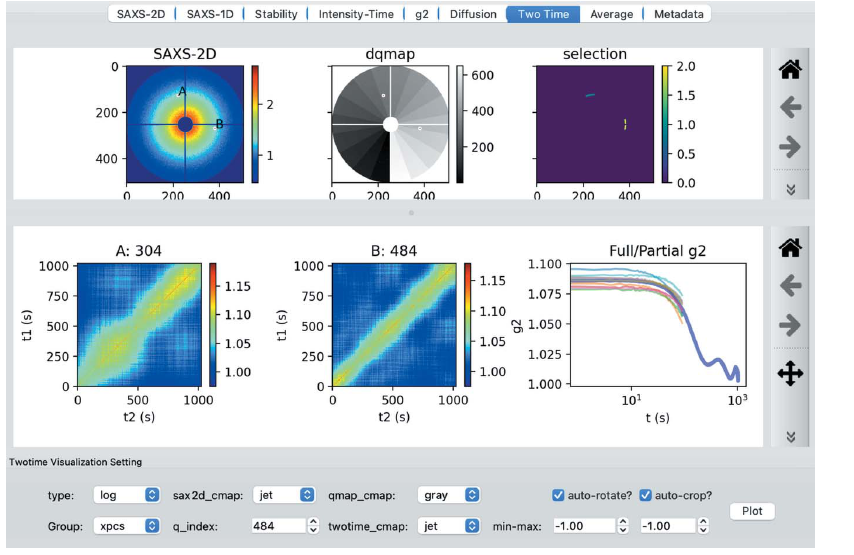
Figure 5 Two-time correlation visualization. The upper panels shows the scattering pattern as well as the dynamical Q -map that allows users to select regions ( A and B ) of interest to explore. The lower panels show the two-time maps for the selected points. The full (blue) and partial (red) g 2 curves for selection B are also displayed.